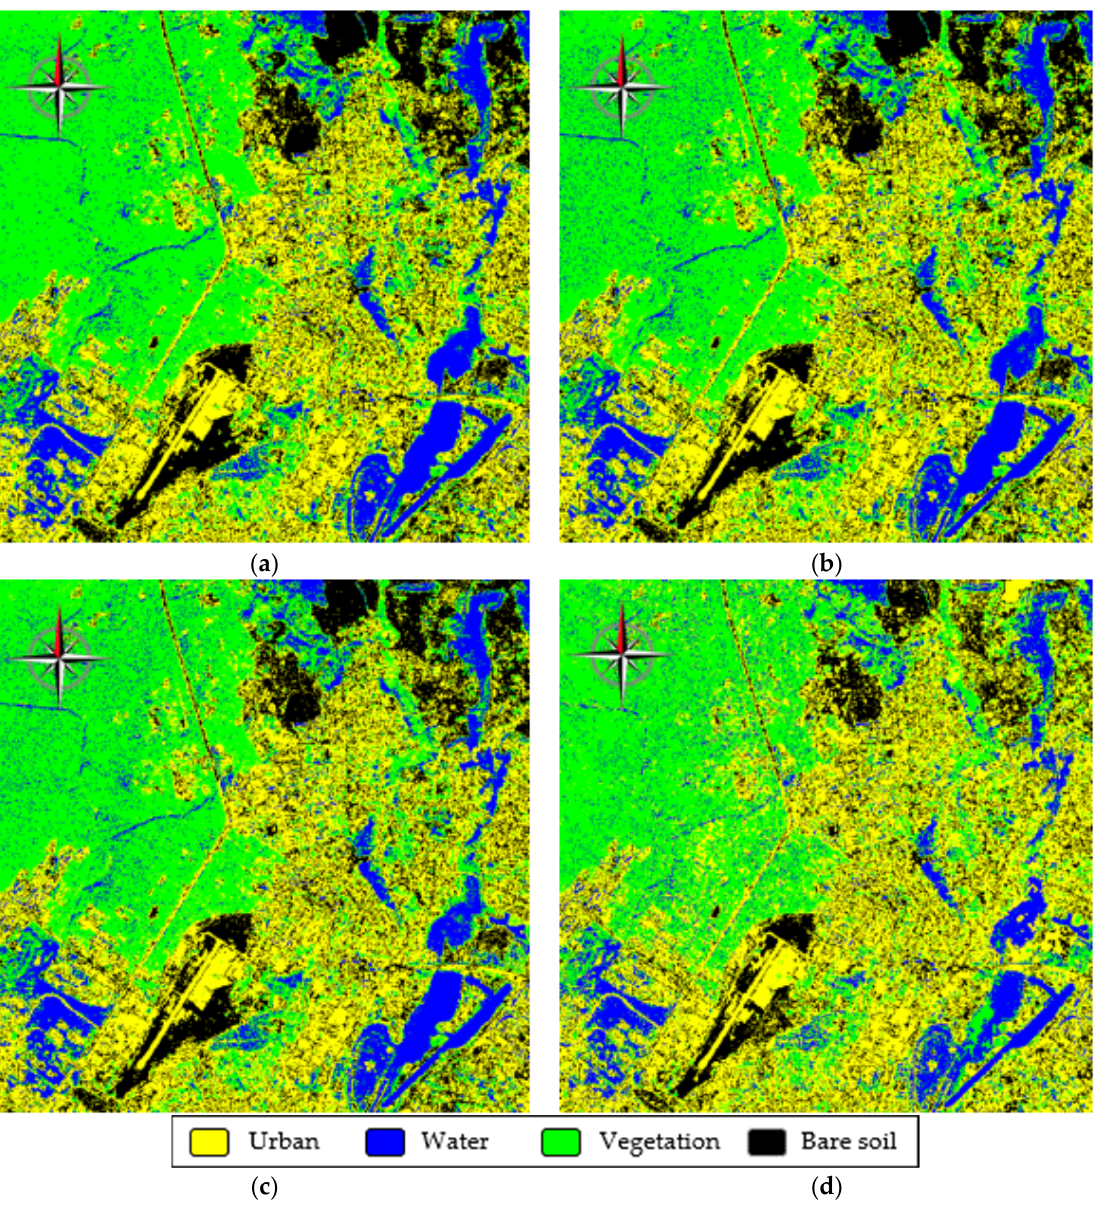
Figure 19. Classification maps for the original image ( a ) and images compressed by DAT with depth 1 with MAD = 4 ( b ), MAD = 11 ( c ), and MAD = 34 ( d ). Table 11. Confusion matrix for original image in Figure 12b.